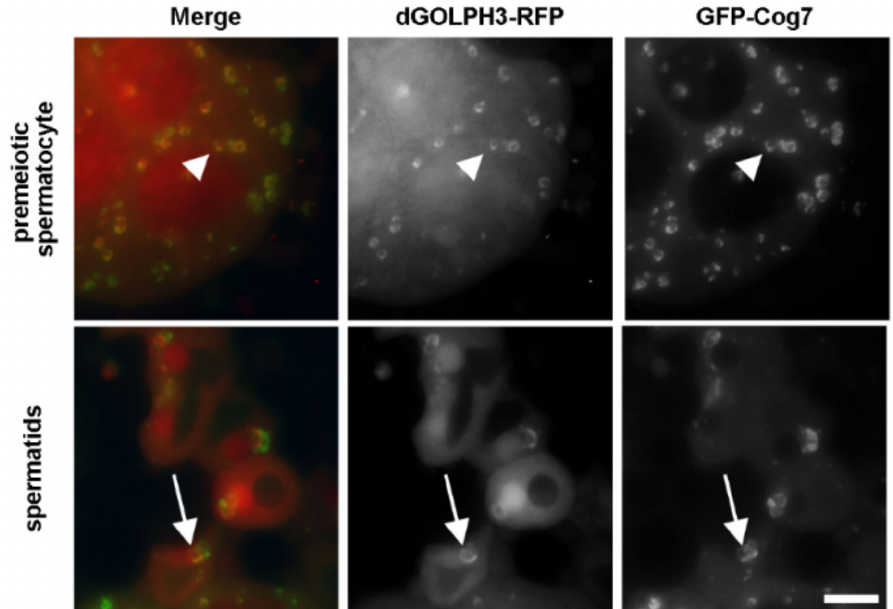
Figure 1. dGOLPH3-RFP localizes to the multiple Golgi organelles in primary spermatocytes and to the acroblast in spermatids. Fluorescence micrographs of live squashed spermatocytes and spermatids expressing dGOLPH3-RFP and GFP-Cog7. Arrowheads point to Golgi stacks; arrows point to the acroblast. Bar, 10 µ